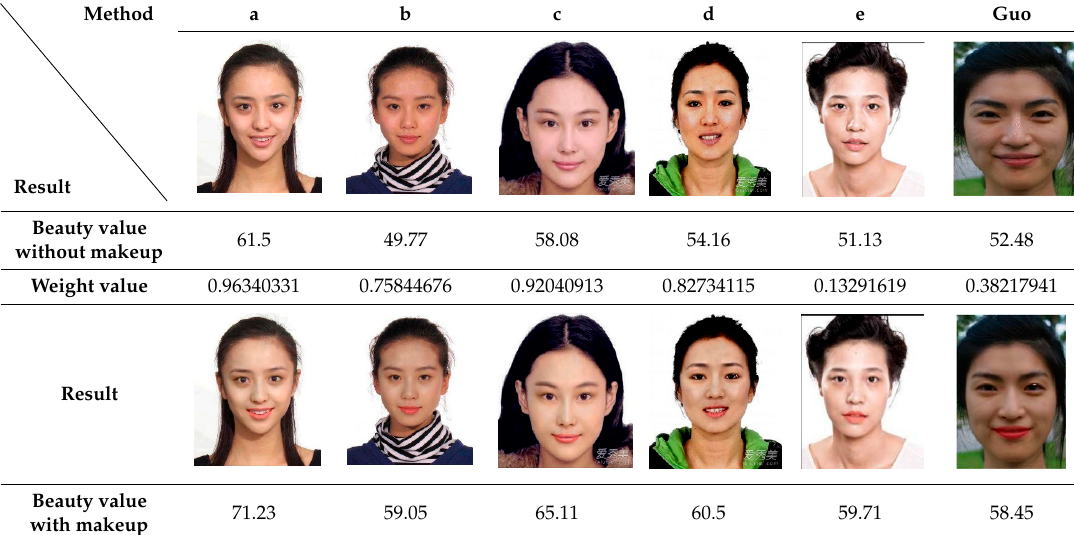
Table 6. Different girls wear the same makeup.